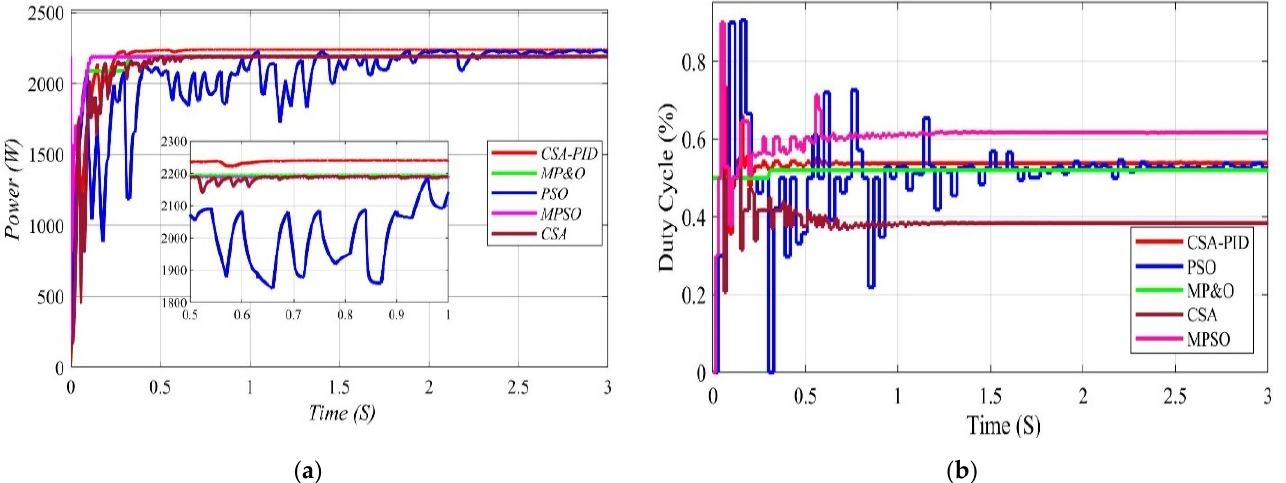
Figure 13. Details of the duty cycle and power of proposed CSA-PID, CSA, MPSO, PSO, and MP&O controllers under scenario one. ( a ) The output power of proposed CSA-PID, CSA, MPSO, PSO, and MP&O. ( b ) The output duty cycle of proposed CSA-PID, CSA, MPSO, PSO, and MP&O.